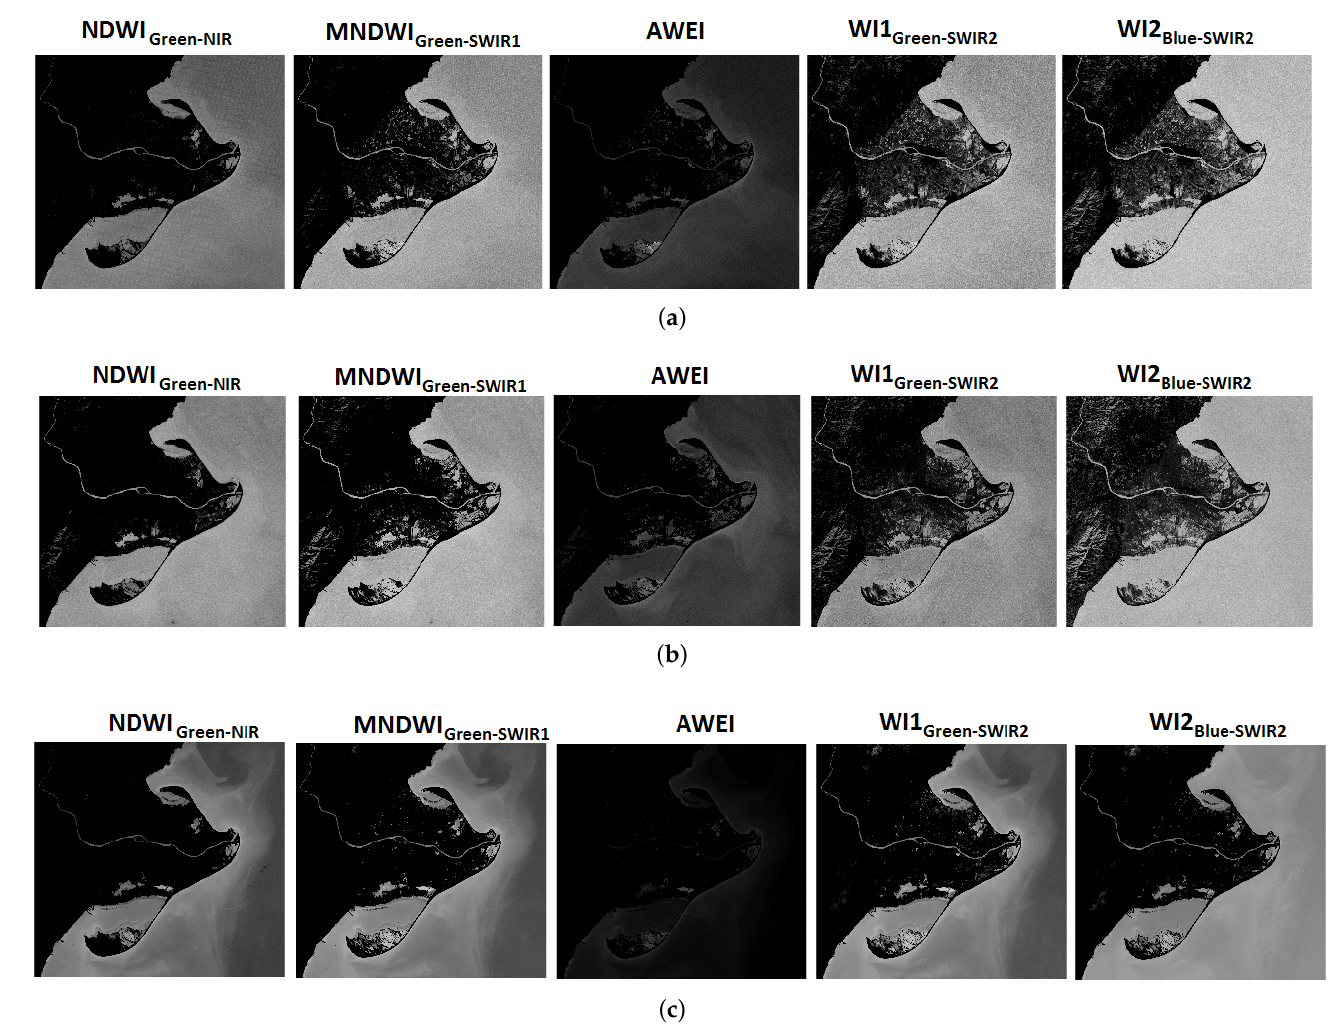
Figure 9. Water indexes calculated for comparison in each of the sensors selected: TM, ETM,+ and OLI in the Ebro River Delta. ( a ) The water indexes calculated on a TM image recorded on 11 October 2011. ( b ) The water indexes calculated on an ETM+ image recorded on 22 Janyary 2000. ( c ) The water indexes calculated on an OLI image recorded on 3 October